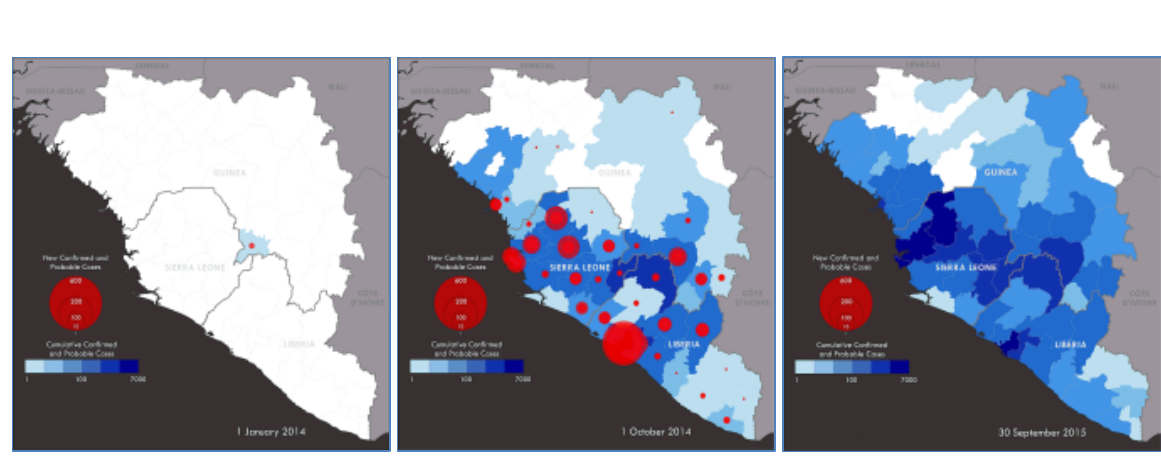
Figure 1: Propagation of the EVD throughout the MRB countries . (World Health